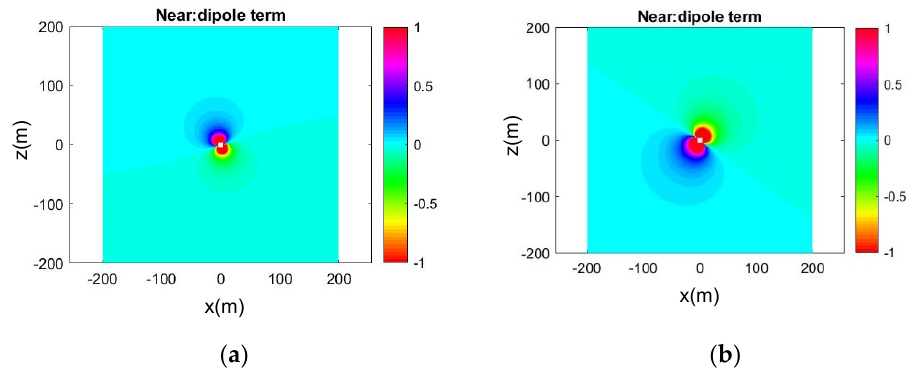
Figure 2. Time snapshots of acoustic field generated by dipole sources in the case of flapping thruster operating in water ( c = 1500 m/s), in the case of foil with NACA0012 sections of Figure 1 flapping at Str = 0.23, h 0 / c = 0.75, θ 0 = 23 deg, using the calculated hydrodynamic loads from a pressure integration 3D BEM method. ( a ) real part, ( b ) imaginary part.